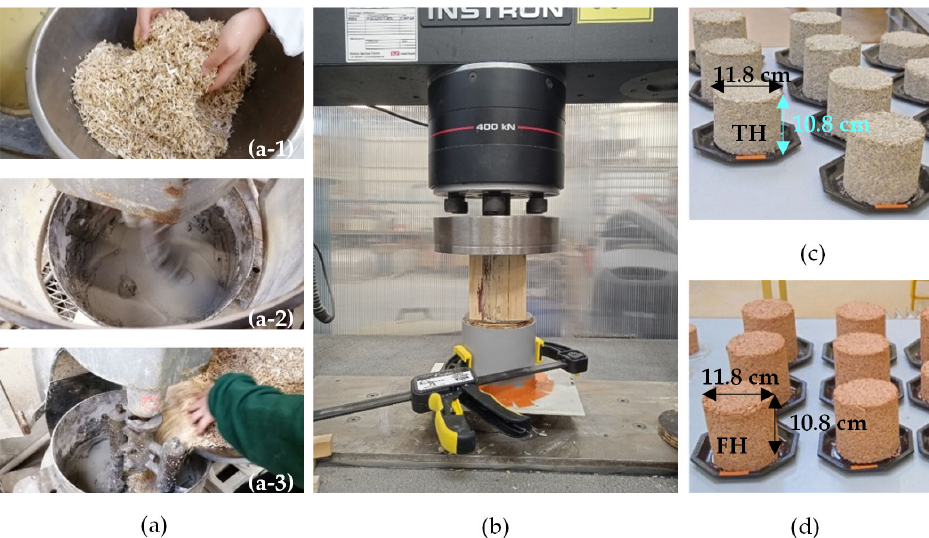
Figure 4. Mixing procedure of thermo-hemp and fine-hemp: ( a - 1 ) manual mixing of hemp shives with water; ( a - 2 ) mixing of binder with water; ( a - 3 ) mixing all components; ( b ) compaction; ( c ) thermo-hemp; ( d ) fine-hemp specimens.